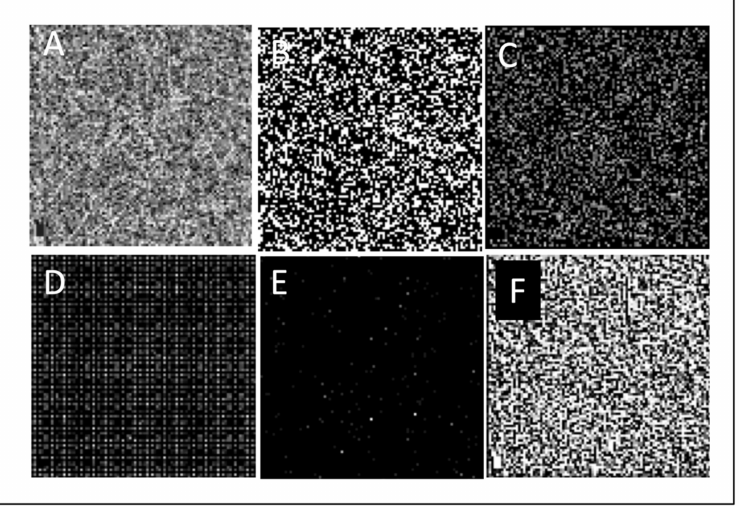
Figure 1. En-face 3 × 3 mm macular OCTA image of choriocapillaris of a young healthy subject ( A ). Texture modification using different filters: Edge filter ( B ), Corner filter ( C ), Histogram of oriented gradients ( D ), Blob localization ( E ), Local binary pattern ( F